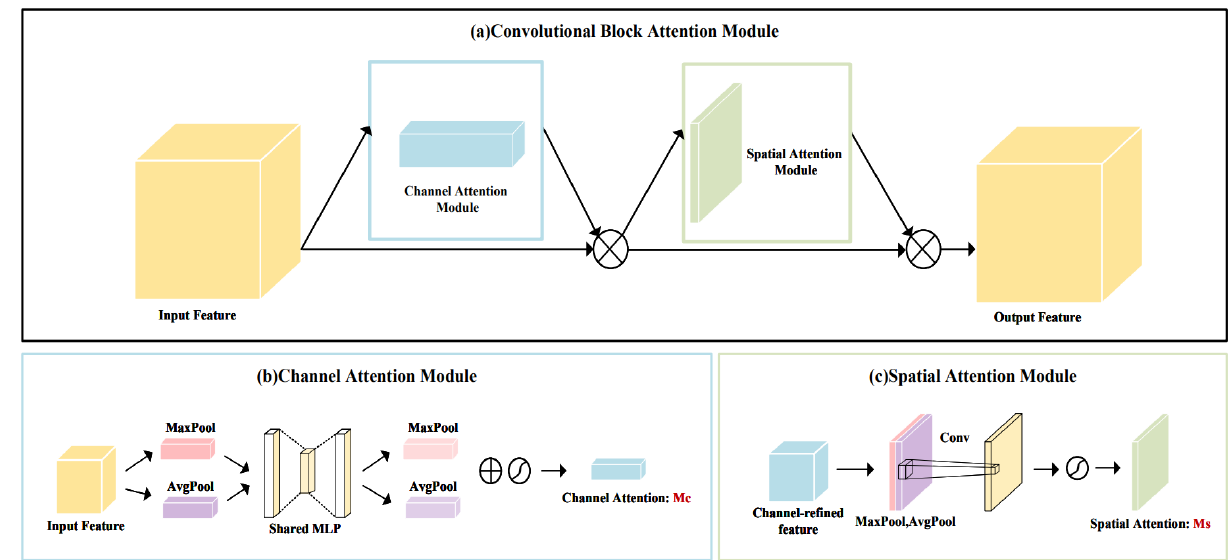
Figure 5. Convolutional block attention module architecture. ( a ) The overall architecture of CBAM. ( b ) The channel attention module. ( c ) The spatial attention module.